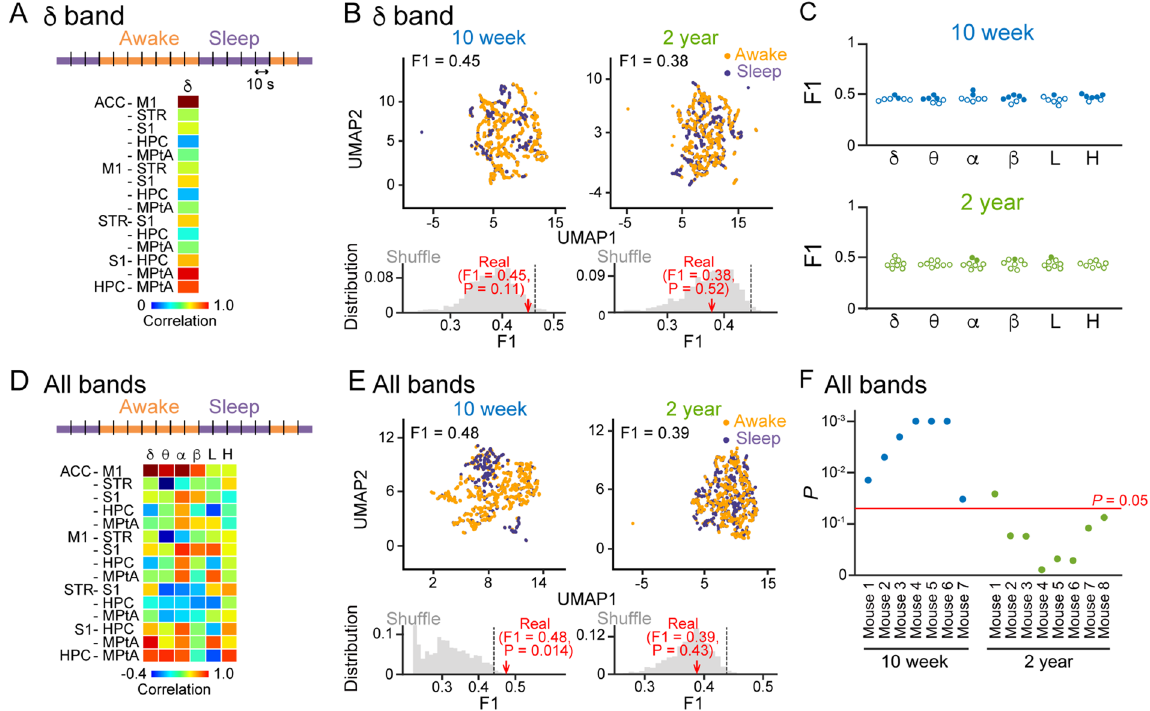
Figure 3. LFP correlational patterns less represented awake and sleep states in aged mice . ( A ) Schematic of analysis. Each 10-s bin was categorized as an awake (orange) or a sleep (purple) bin based on EMG signals, and correlations of power changes in a frequency band across the 15 region pairs were concatenated in a column. ( B ) (Top) Visualization of single-mouse data by UMAP plots. Orange and purple dots represent awake and sleep 10-s bins, respectively. F1 scores to quantify the separation of awake/sleep states from LFP patterns are shown above. (Bottom) The F1 score shown in the top panel (real, red arrow) was compared with a distribution of F1 scores computed from 1000 shuffled datasets in which awake/sleep states of all the plots were randomly shuffled (gray distribution). For each original F1 score, its significance was represented as a P value defined from the ranking compared with surrogate F1 scores. ( C ) F1 scores computed in individual frequency bands. Each dot represents an individual mouse. The closed and open circles represent significant and nonsignificant data, respectively. ( D , E ) Same as A and B, but correlations in the six frequency bands were used for the UMAP analysis. ( F ) For individual mice, P values for original F1 scores were computed from datasets including all six frequency bands. The horizontal red line indicates P = 0.05, showing the significance. MATLAB R2021b (https:// jp. mathw orks. com/ produ cts/ new_ produ cts/ relea se202 1b. html), Illustrator 26.2.1 (https:// www. adobe. com/ jp/ produ cts/ illus trator. html) and Python 3.10.4 (https:// www. python. org/ downl oads/ relea se/ python- 3104/) were used to create this